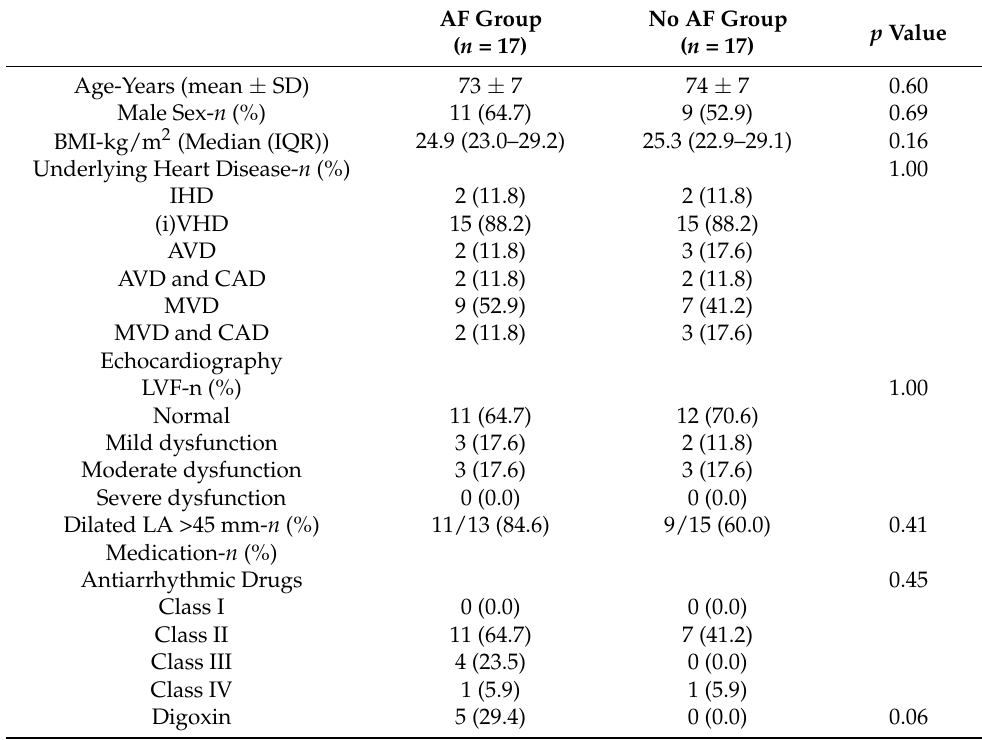
Table 1. Characteristics of